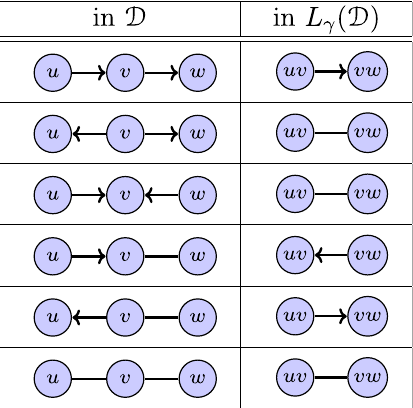
Figure 1: Construction of the γ - line graph ( ) (cid:3) L γ